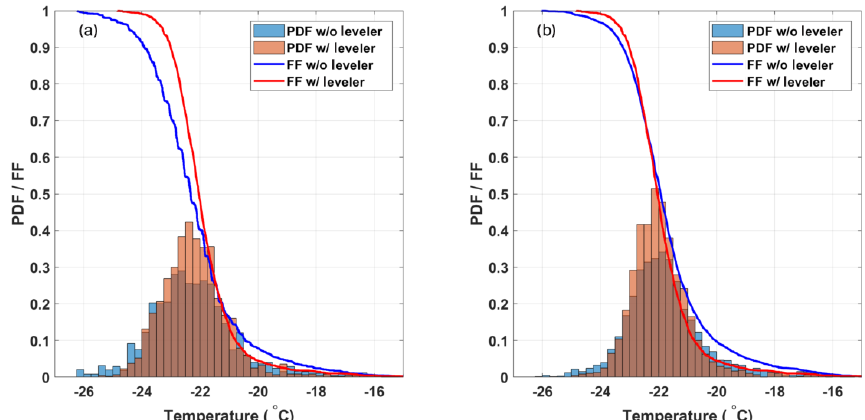
Figure 7. (a) Comparison of the freezing temperature of SA water without (32 experiments; blue) and with (20 experiments; red) the bath leveler. The histograms are normalized to represent the PDF of the freezing temperatures, and the lines represent the mean FF curves of the SA water experiments. (b) Shows the same as panel (a) except that a bias correction is applied to both sets of experiments.